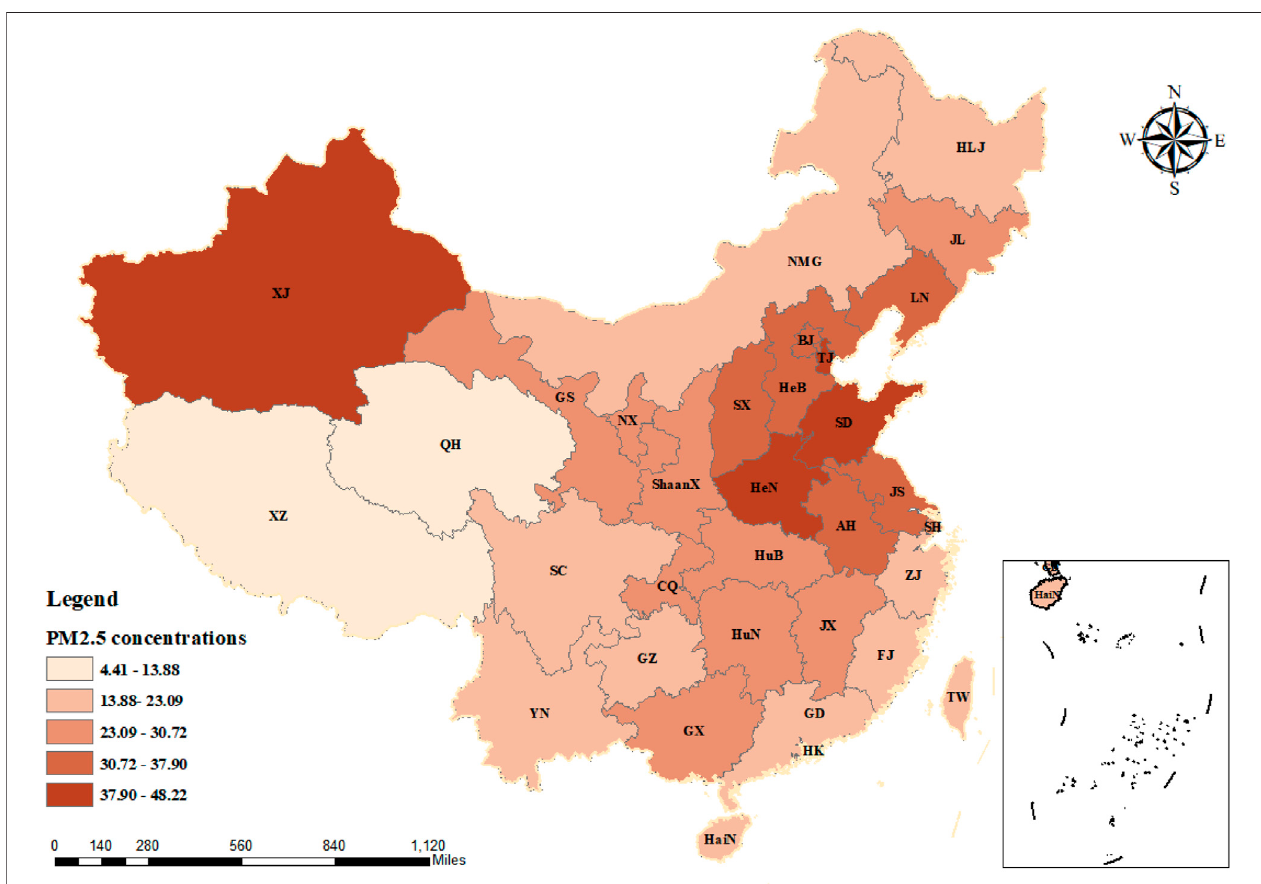
FIGURE 1 | PM 2.5 concentration in China in